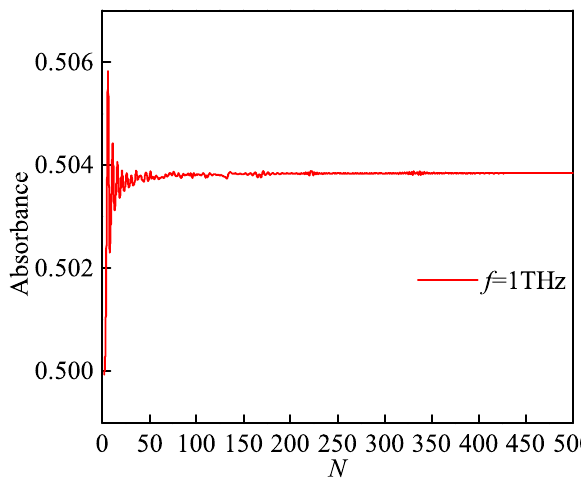
Figure 2. Absorbance versus the number of sub-layer under 1 THz.